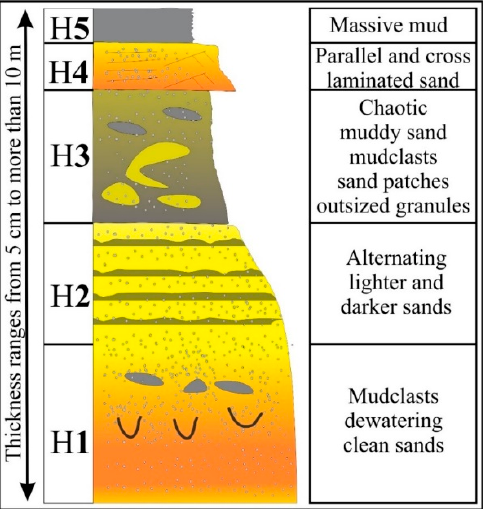
Figure 3. A simple hybrid event bed facies model proposed by Haughton et al. [19] , showing five hybrid bed facies or divisions from base H1 to top H5. The basal H1 facies comprises massive sand with dewatering and broken mud clasts, the H2 hybrid event bed facies consists of alternate lighter and darker banded sandstone, H3 has muddy sand with chaotic features both of sand clasts and mud clasts, the H4 facies is formed with fine sand with parallel and cross laminations, and the H5 facies is linked with massive mudstone or shale.